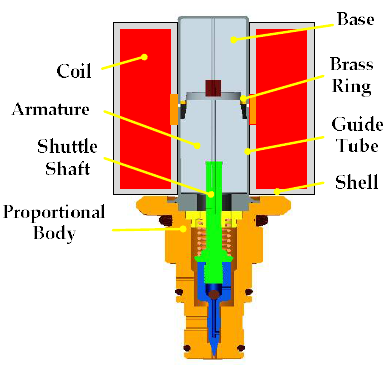
Figure 4. Configuration of proportional pressure control valve for PEHB actuator. Appl. Sci. 2018 , 8 , x FOR PEER REVIEW